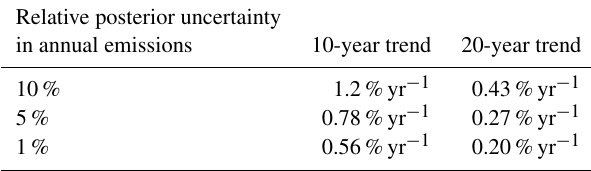
Table 3. Uncertainties in the regressed linear trends as a function of the posterior uncertainty in annual emissions. The uncertainties in the trends are defined as the ratio between the uncertainties in the linear regression slope of absolute annual emissions and the annual emission budget in the base